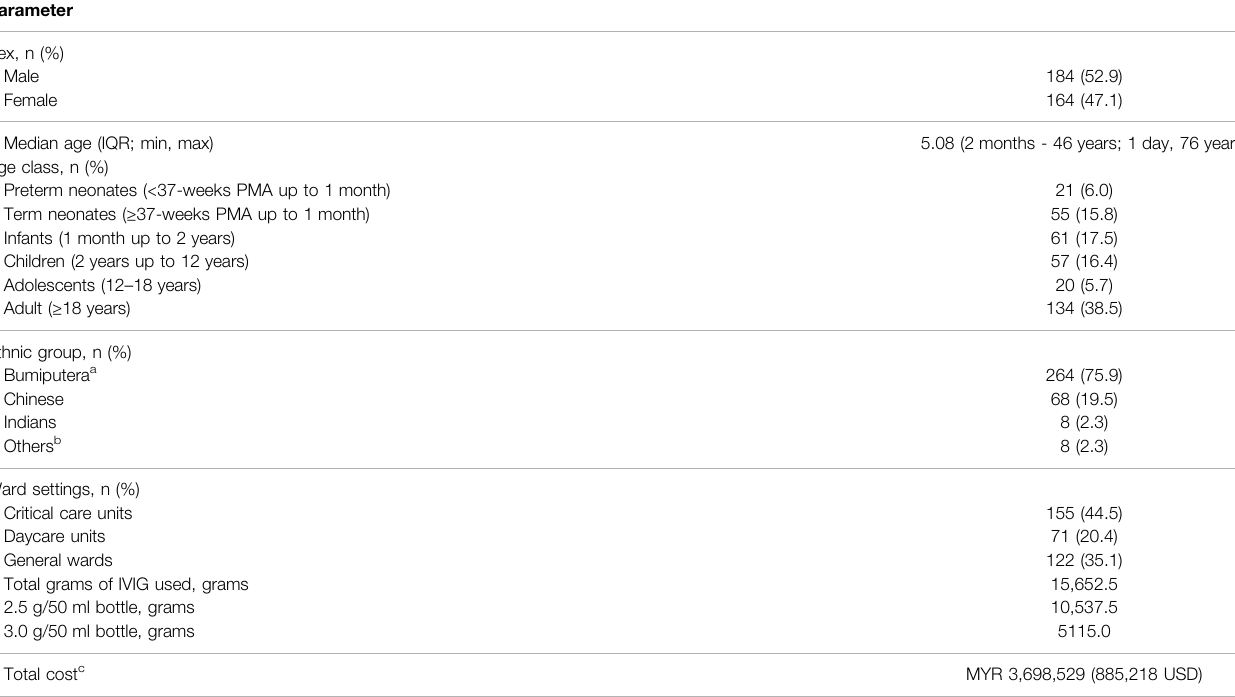
TABLE 1 | Summarized data of included prescriptions ( n = 348).